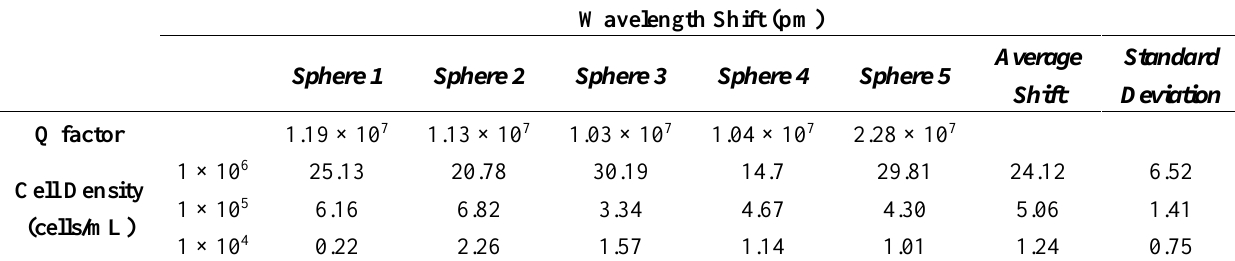
Figure 5. An overlay of the wavelength shift over time for a single representative silica microsphere (sphere 4, referenced in Tables 1 and 2) used in the sensing experiments. Table 1. Wavelength shift seen for each cell density tested. Wavelength shift correlates to concentration. The Q factors of the spheres, in air, just prior to the beginning of the sensing experiments, are also given.